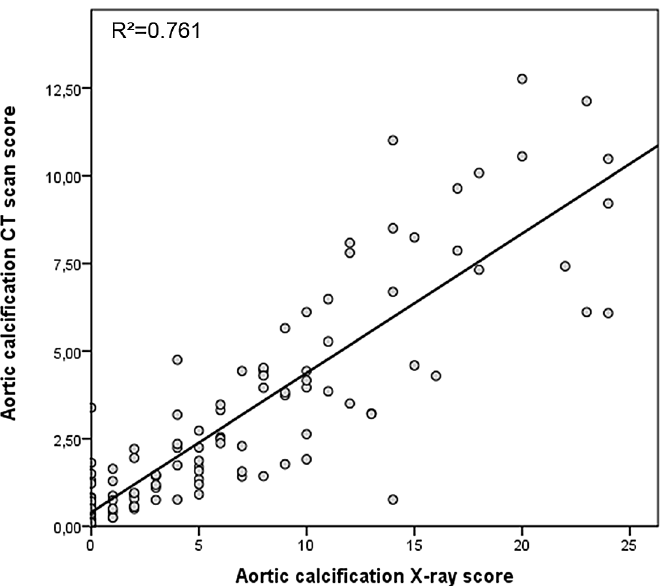
Fig 1. Linear regression curve. Relationship between the aortic calcification scores based on a CT scan or on X-ray data (n = 143, r 2 = 0.761, p >